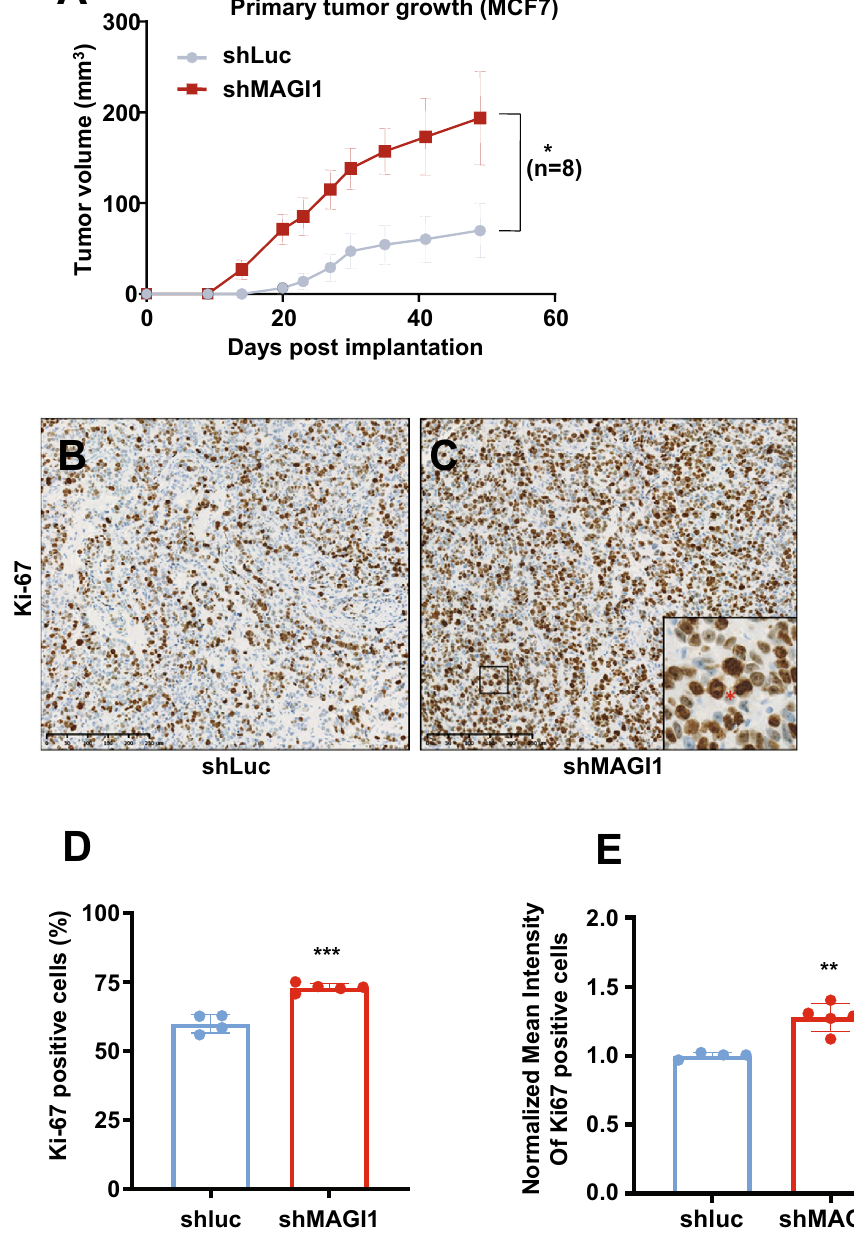
Figure 2. The loss of MAGI1 in primary tumors induces tumor cell proliferation. ( A ) Primary tumor growth of MCF7 shLuc and MCF7 shMAGI1 cells injected subcutaneously in nude mice. Primary tumor growth was assessed by measuring the tumor volume over time until the tumors were too big and the mice had to be euthanized. Bars correspond to the mean ± Standard Error to the Mean (SEM; n = 8 mice per group). Unpaired two-tailed Student’s t-test; * p < 0.05. ( B , C ) Representative immunohistochemical staining of Ki67 in primary tumors obtained after subcutaneous engraftment of either MCF7 shLuc ( B ) or MCF7 shMAG1 cells ( C ). Brown staining indicates positive immunoreactivity. Scale bar = 250 µM. In the magnified area, the red * highlights an increased number of mitotic cells in the MCF7 shMAGI1 -derived primary tumor. ( D , E ) Quantification of the immunohistochemical analysis in ( B , C ), showing the percentage of primary tumor cells stained positively for Ki67 ( D ) and the normalized mean intensity of Ki67 positive cells ( E ) in MCF7 shMAGI1 and MCF7 shLuc primary tumors. Bars correspond to the mean ± SD (n = 4 for shLuc and n = 5 for shMAGI1 ). Unpaired two-tailed Student’s t-test; ** p < 0.01 and *** p <